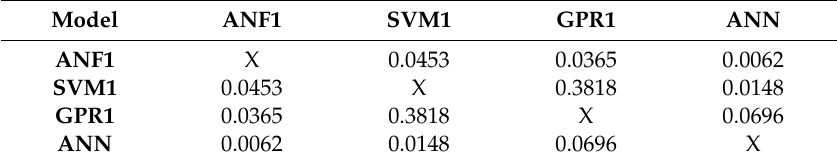
Table 7. Resultant p -values of comparing di ff erent models with t -test (experimental